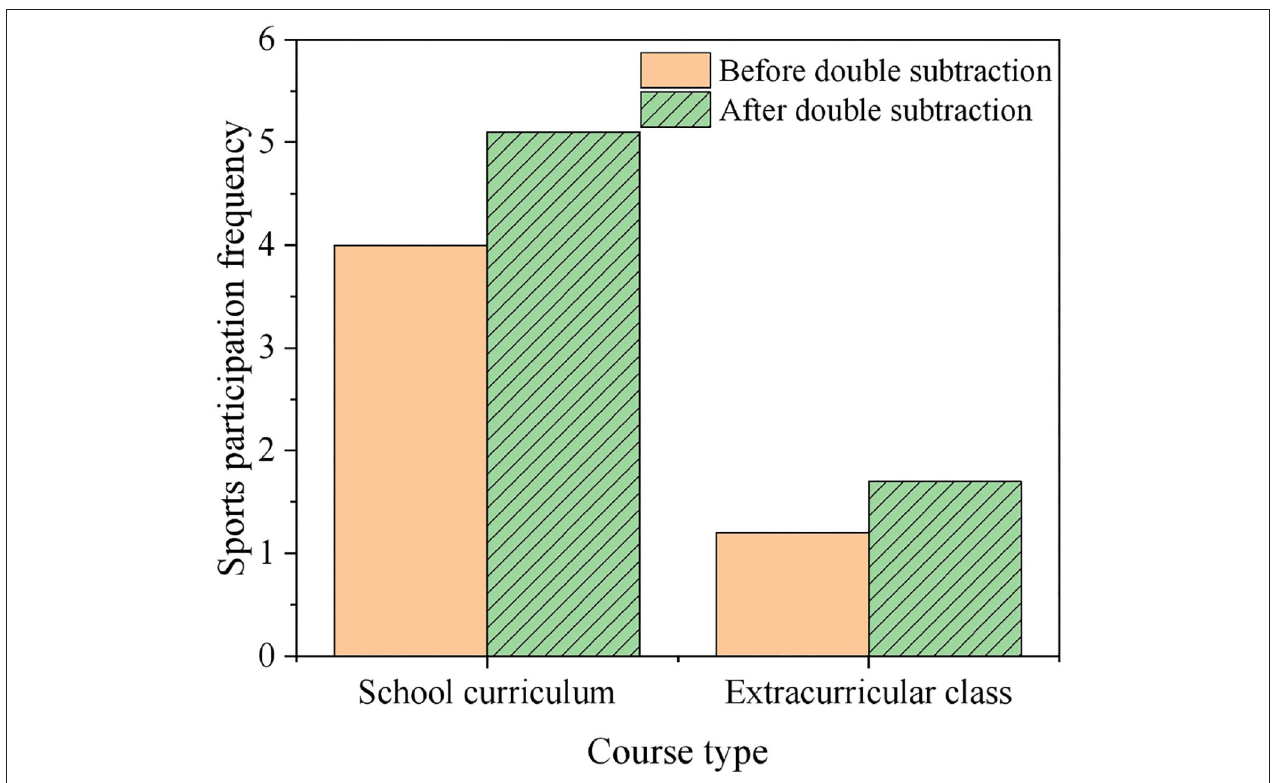
FIGURE 7 | SP frequency before and after “DR”.